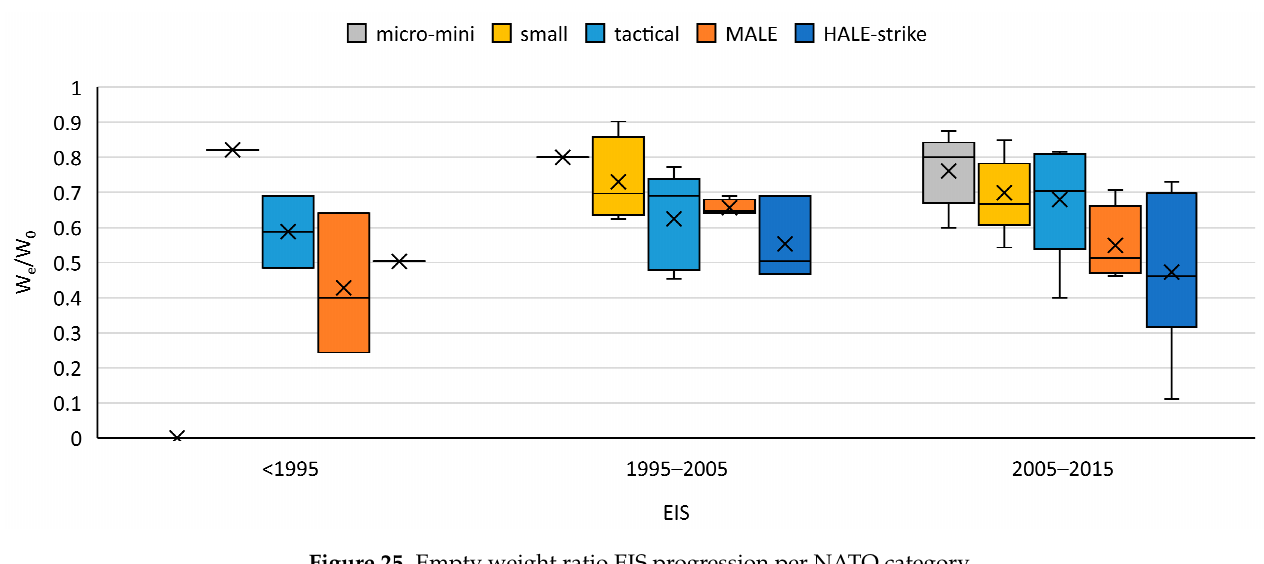
Figure 24. Payload weight over GTOW ratio EIS progression per NATO category.